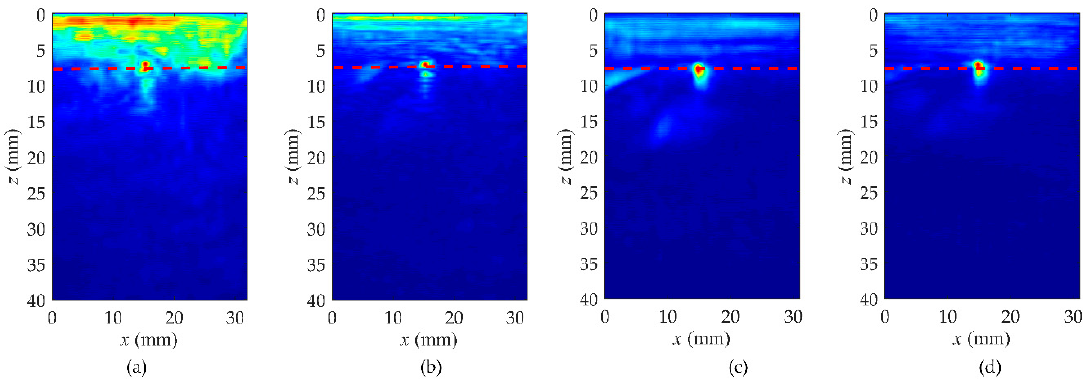
Figure 12. The study about the starting time, T c , of the time-windowed diffuse field signals in rail A. ( a ) T c = 200 μ s, ( b ) T c = 300 μ s, ( c ) T c = 400 μ s, ( d ) T c = 500 μ s.